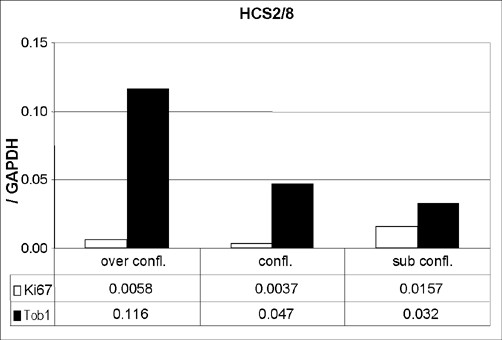
Comparative mRNA analysis for Tob1 and proliferation associated Ki-67 mRNA expression in chondrocytic HCS-2/8 cells. HCS-2/8 cells were cultured in sub-confluent, confluent, and over-confluent conditions and the Tob1 mRNA levels determined by qPCR (shown are the ratios to glyceraldehyde-3-phosphate dehydrogenase (GADPH)).